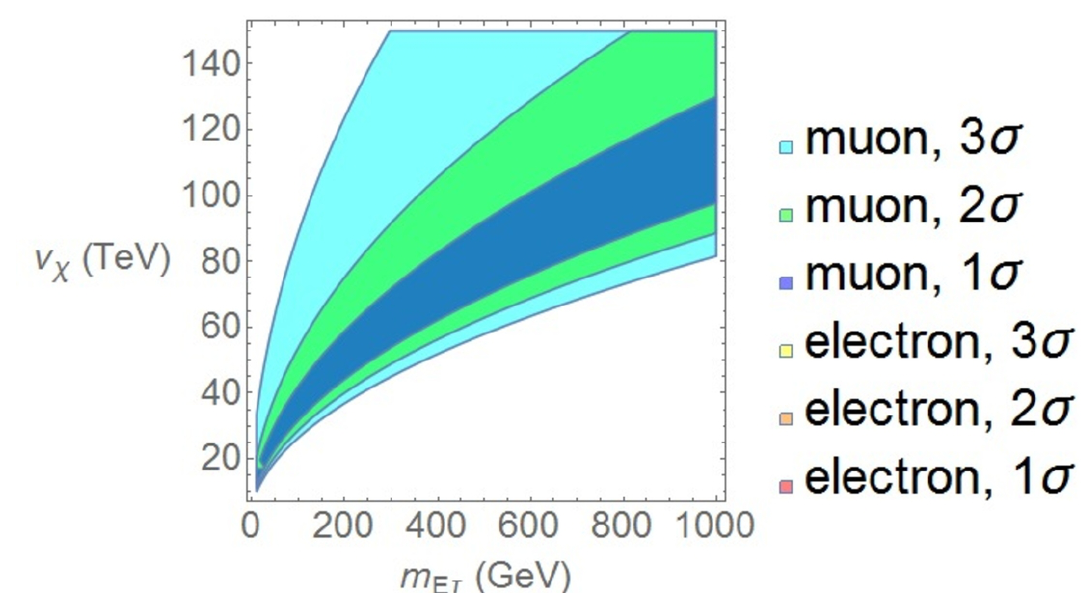
Figure 15 . v (cid:31) and m E values satisfying eq. (3.1) within 1 (cid:27) , 2 (cid:27) and 3 (cid:27) . Here we used the fourth e set of diagonalization matrices (see section 4.2.5) and considered: m E and m = m = m = 1000 (all in GeV). The masses of the exotic gauge bosons ( U (cid:6)(cid:6) and A 0 Y ++ Y + 1 Z 0 ) have their values de(cid:12)ned by the value of v (cid:31) , since its other parameters are already (cid:12)xed (see [37] for